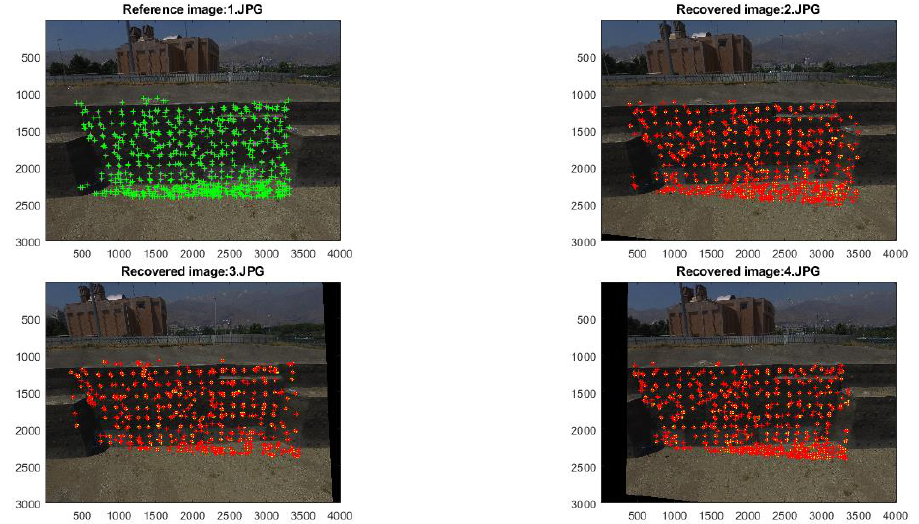
Figure 7. Three examples of the homographic images projected on the reference image.